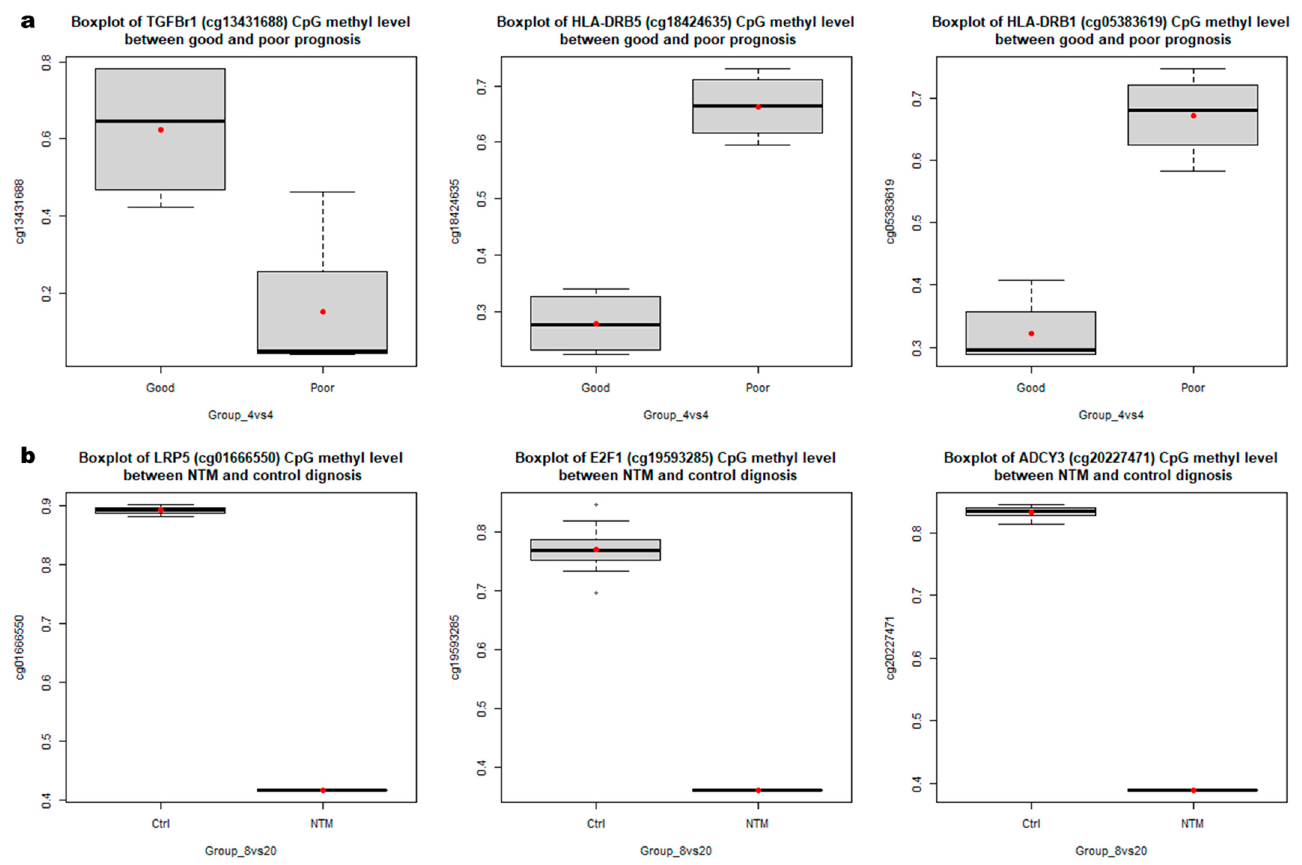
Figure 4. Comparison of the levels of the top three DMRs between ( a ) NTM patients with good and poor prognoses, as well as ( b ) between NTM patients and the healthy controls. * ANCOVA was used to adjust the age, sex, BMI, and underlying diseases for epigenetic markers. All P -values were <0.001.